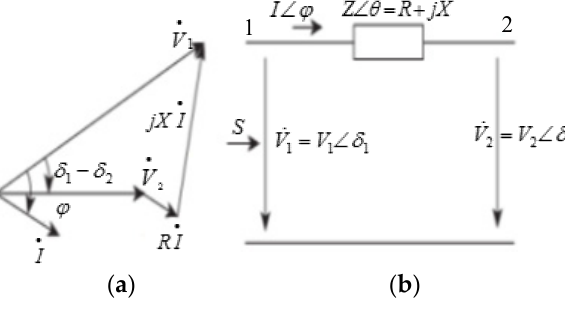
Figure 2. Power flow in MG. ( a ) Voltage vector; ( b ) power flow.